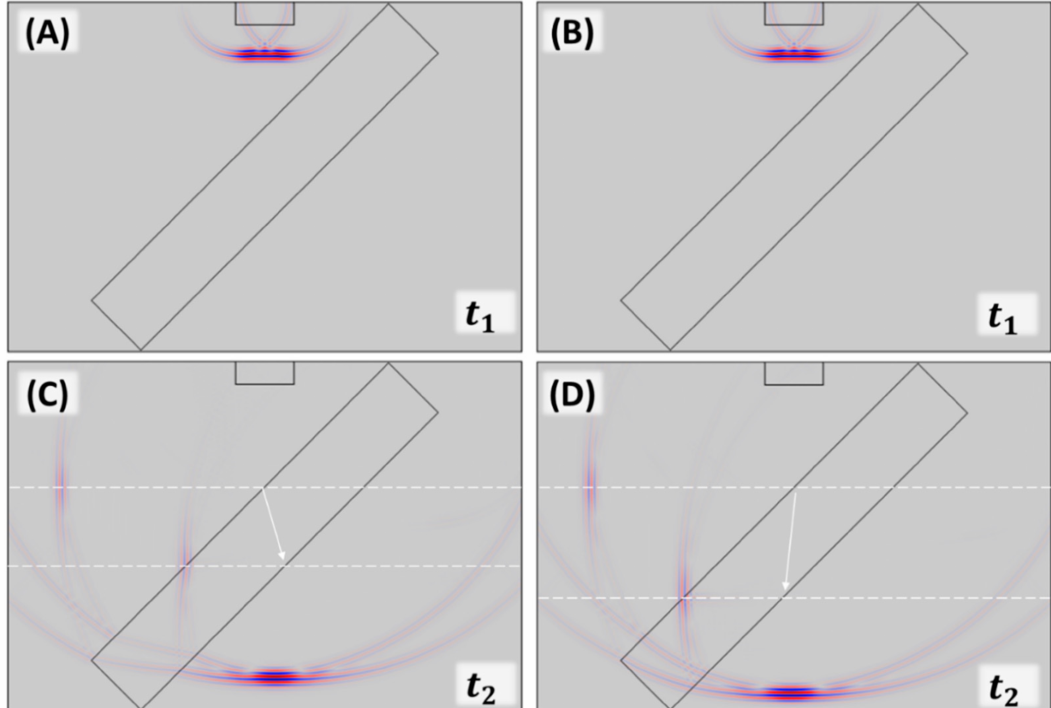
Figure 3. ( A ) Time-domain simulation of sound pressure field showing the incident pulse at 20 ◦ C. ( B ) Time-domain simulation of sound pressure field showing the identical incident pulse from ( A ) at 39 ◦ C and t 1 . ( C ) Separated pulses at 20 ◦ C and t 2 . ( D ) Separated pulses at 39 ◦ C and t 2 . The white dash lines indicated the vertical position of the pulses’ center. The white arrows referred to the propagation paths in the hydrogel